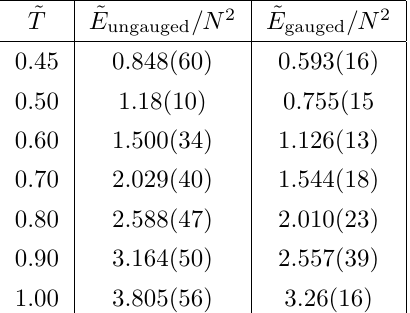
Table 1. Data for the internal energy of the ungauged and gauged theories in the large- N contin- uum